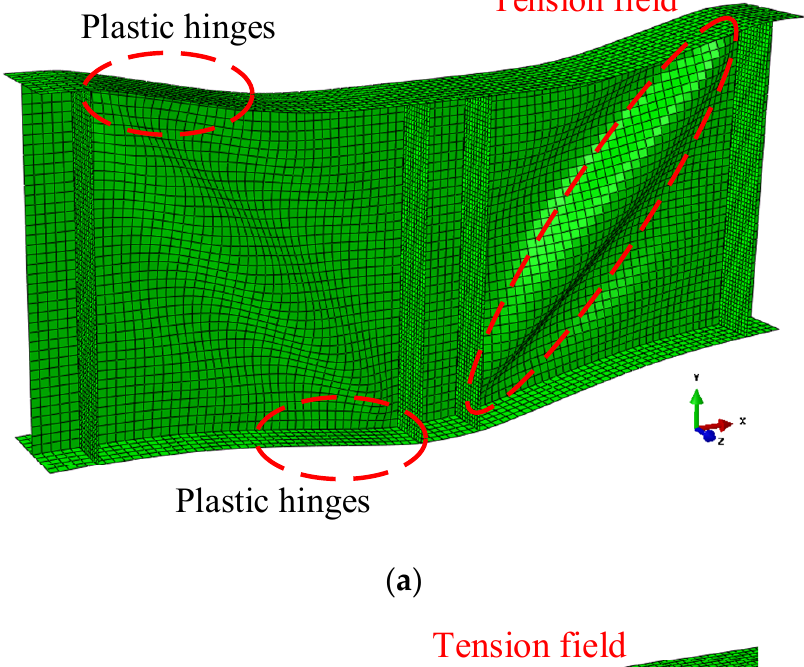
Figure 9. Structure form of plate girder model.